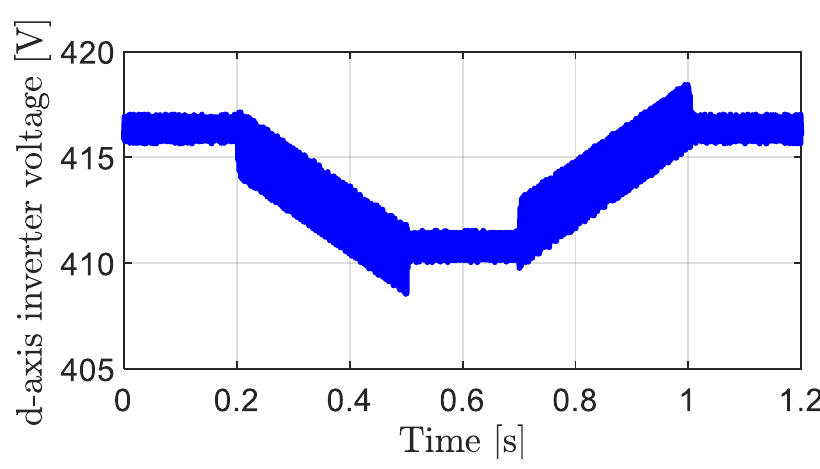
Figure 8. d -axis component of the inverter voltages vector e d(i) .